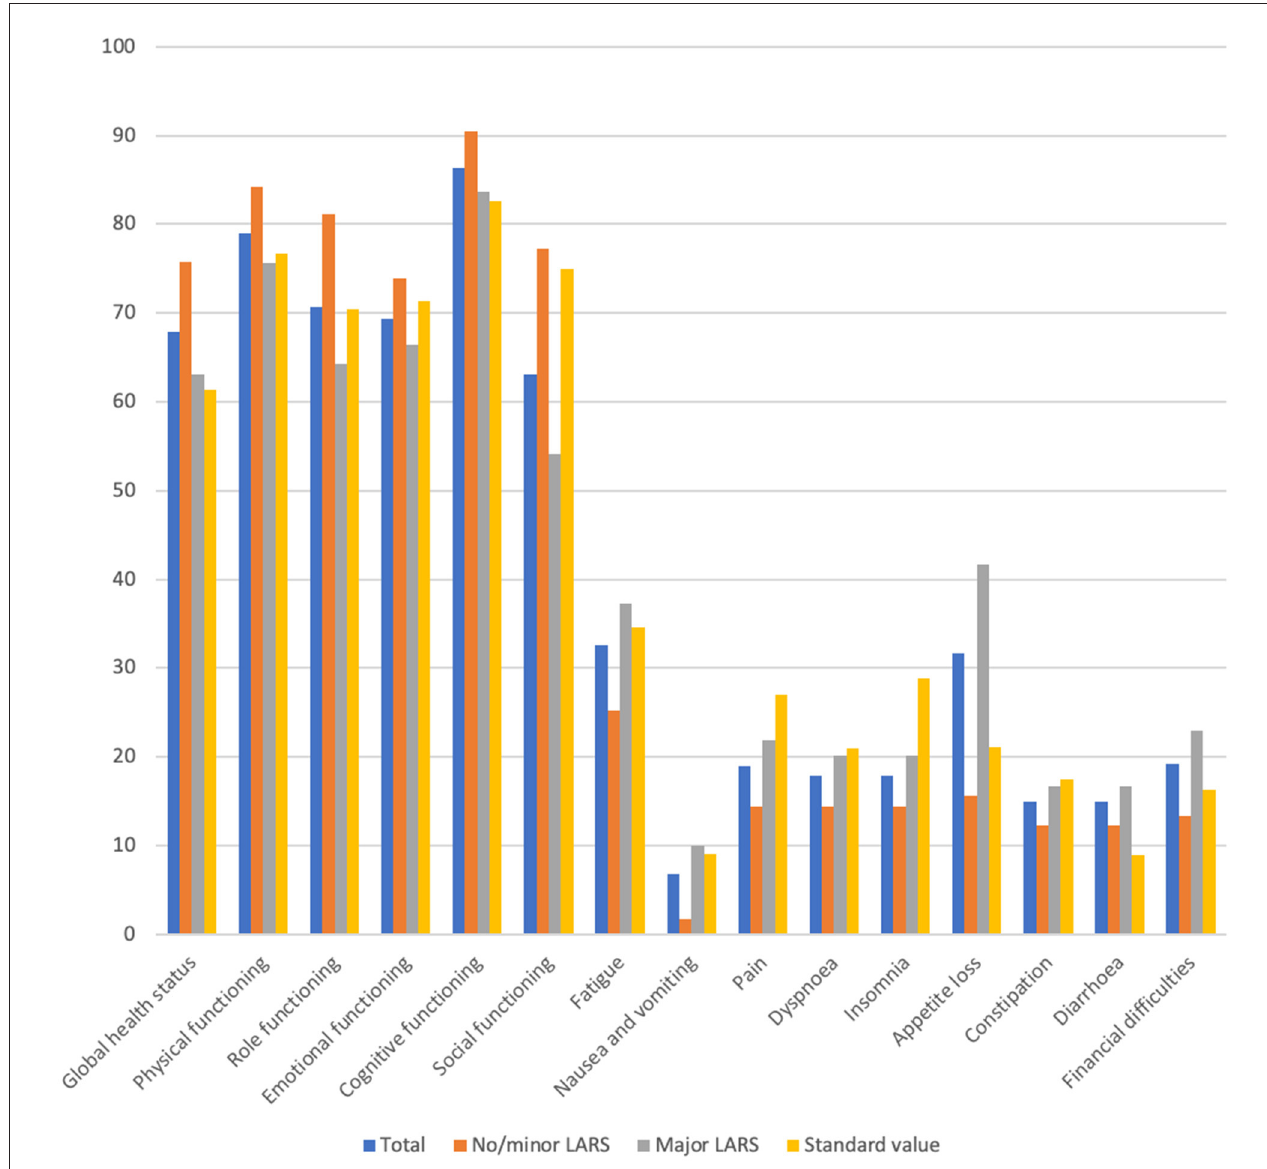
FIGURE 3 | Global health relatated quality of life (mean). According to the EORTC-scoring manual a high score in fuctional scales represents a high functional level wehreas a high score in symptom scales correlate with a high level of symptoms.